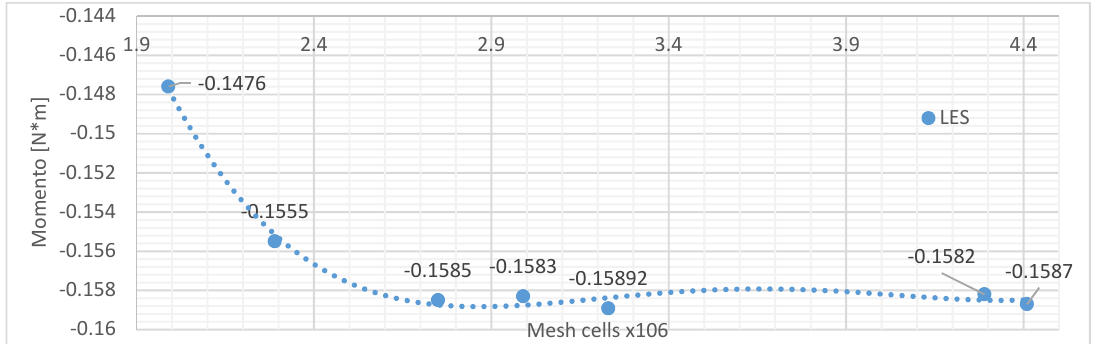
Figure 13. Mesh independence.